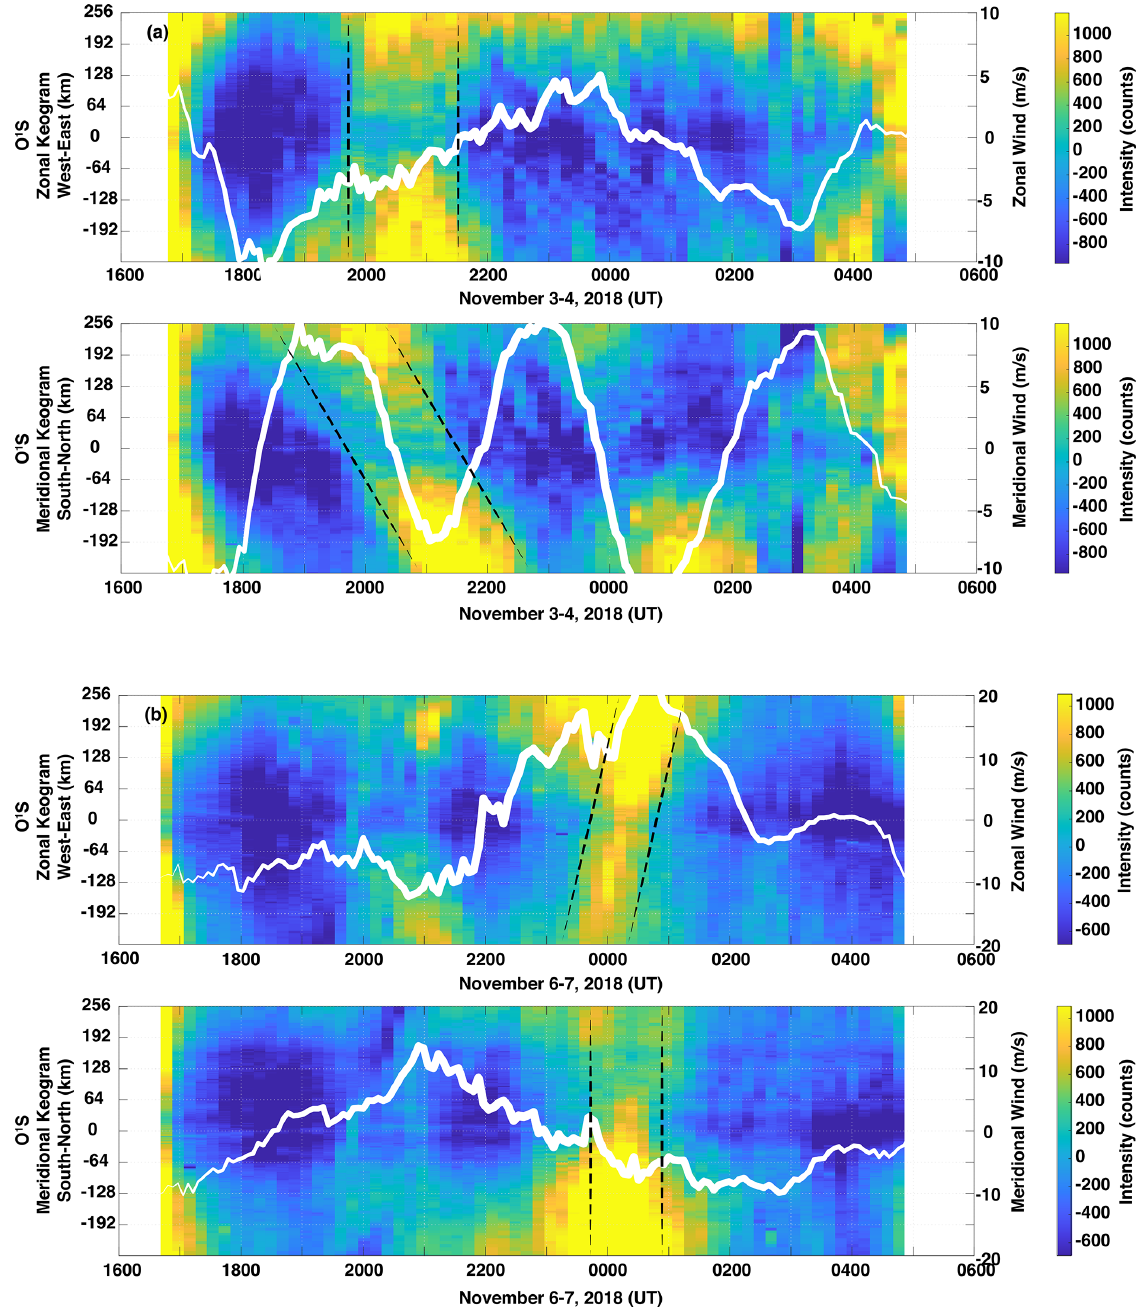
Figure 8. Enhanced contrast keograms of O( 1 S) airglow for (a) 3–4 November and (b) 6–7 November 2018. The keogram of 3–4 November shows a large-amplitude, large-scale gravity wave at 20:00–22:00UTC heading south. A large-scale wave is also seen on 6–7 November propagating eastward at 00:00UTC. The white continuous lines on the keograms indicate the wind fluctuations weighted by the O( 1 S) volume emission